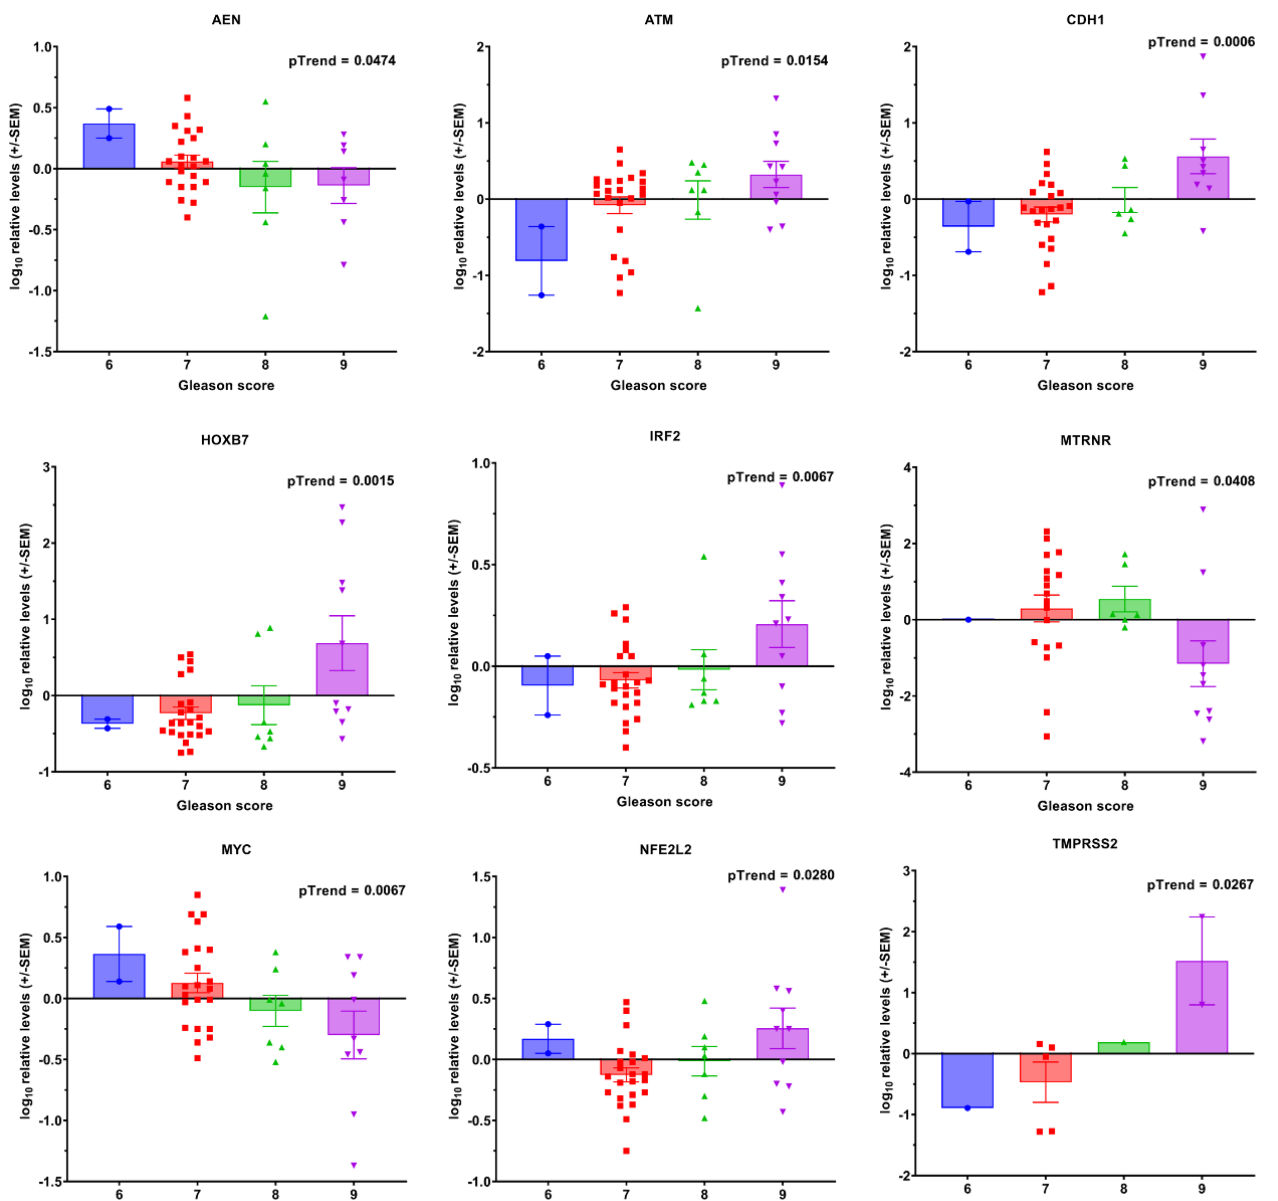
Figure A1. Significant associations between transcripts’ expression in blood-derived mRNA and Gleason score in overall cohort. Bar graphs showing − log10 relative expression levels of gene transcripts in different Gleason score groups. p values are indicated after linear test for trend following ANOVA.